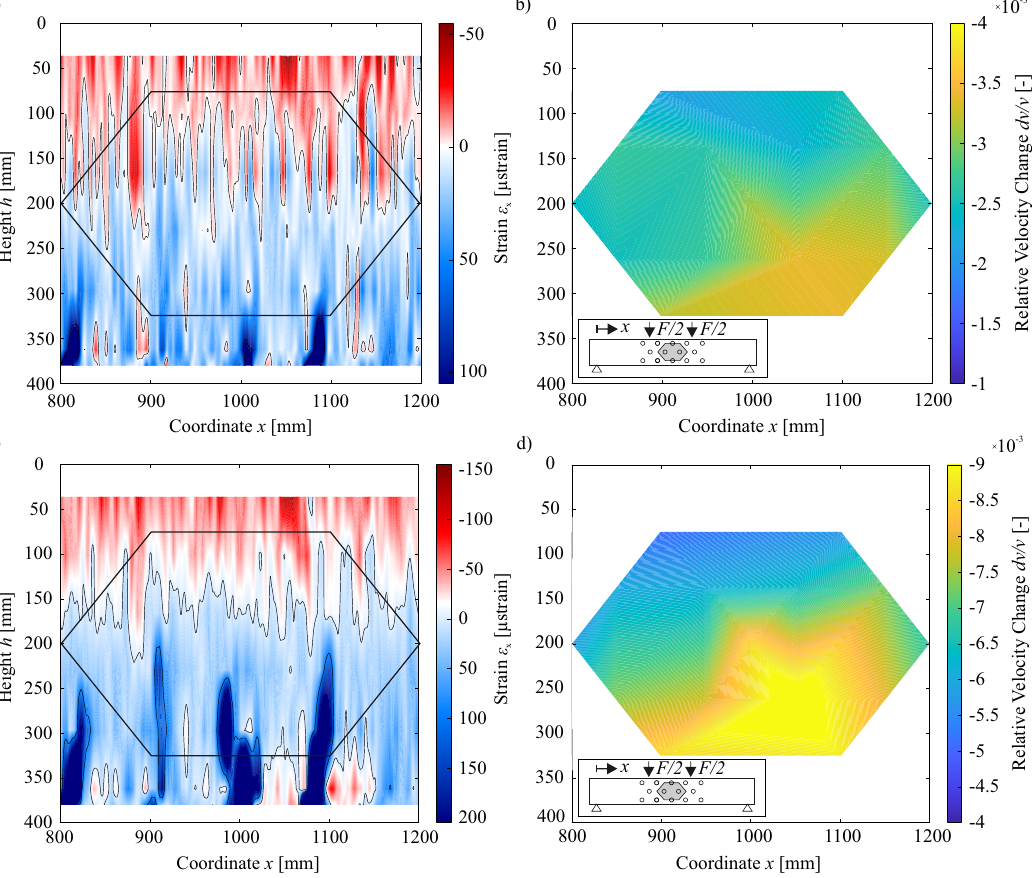
Figure 9. ( a , c ) Strain fields derived by FOS measurements assigned to their respective heights, ( b , d ) Relative Velocity Change presented as Attribute Maps. The two upper figures show the respective results for a load of F = 10kN, while the two lower Figures do so for F =